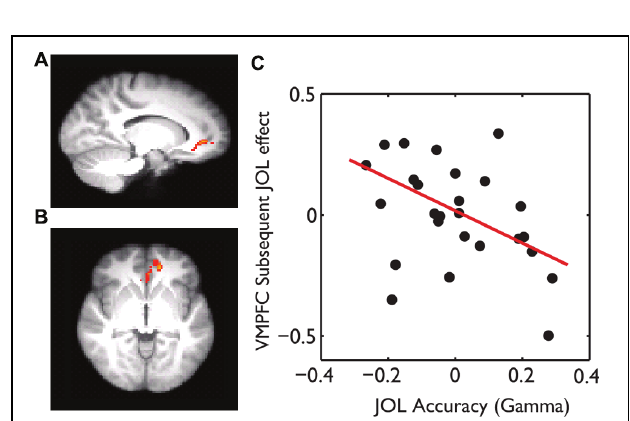
FIGURE 4 | The effect of JOL accuracy on the subsequent JOL effect. The VMPFC showed a negative correlation between JOL accuracy (gamma) and the subsequent JOL effect, which was overlain on the saggital (A) and axial (B) slices of the group average anatomical image. (C) Scatter plot of the JOL accuracy and the subsequent JOL effect at the VMPFC. The regression line was based on the robust fit, which was less sensitive to the influence of